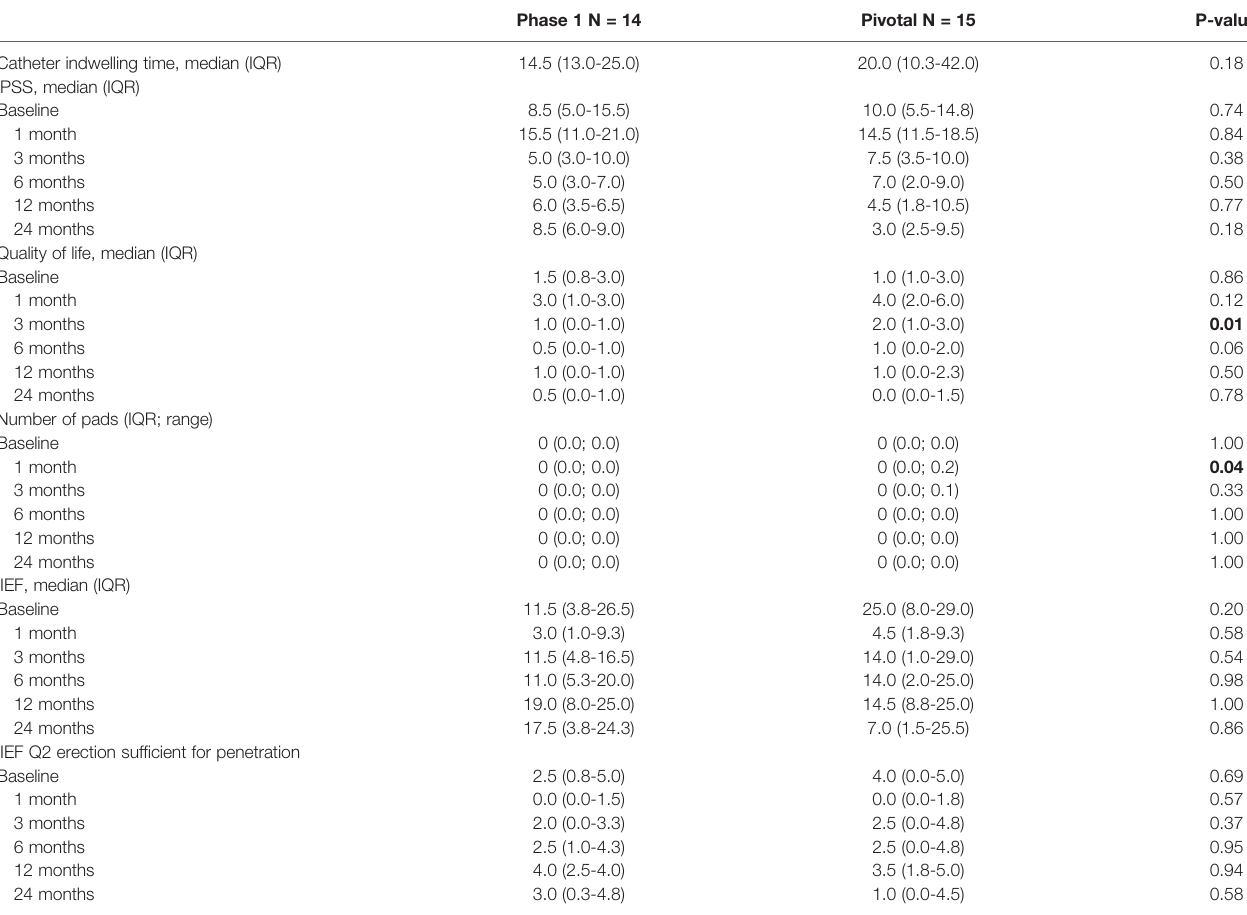
TABLE 4 | Functional follow-up: Comparison of catheter indwelling time, IPSS, quality of life and pad usage for evaluation of micturition and IIEF questionnaire data for erectile function at baseline and during follow-up for phase 1 and pivotal trial patients. Phase 1 N = 14 Pivotal N = 15 Catheter indwelling time, median